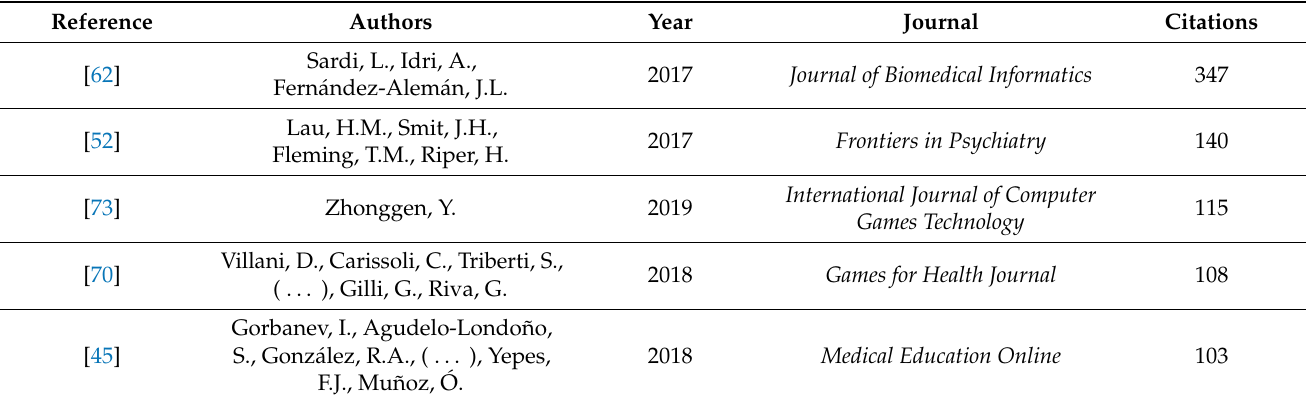
Table 6. Most cited (over 100 times) systematic reviews (up to 23 October